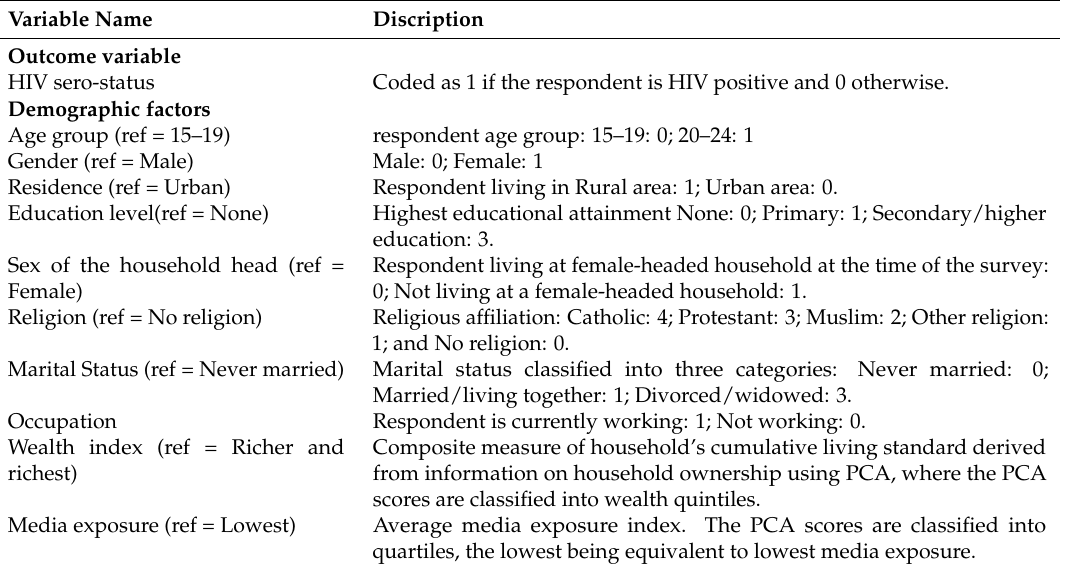
Table A1. Description of the variables used in the